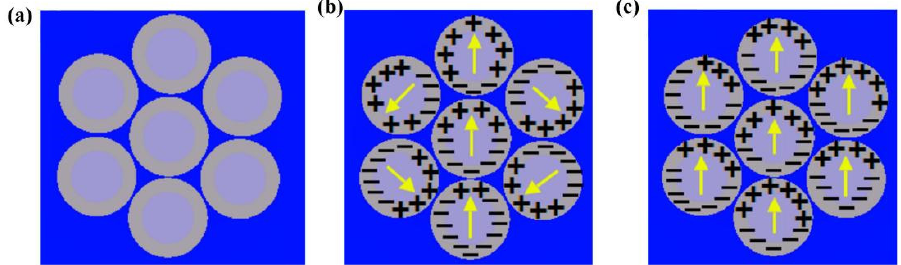
Figure 2. ( a ) The schematic diagram for the nanoshell heptamer. Adapted with permission from Ref. [65]. ( b ) The hybrid bonding mode. ( c ) The hybrid anti–bonding mode. Ref. [65]. ( b ) The hybrid bonding mode. ( c ) The hybrid anti–bonding